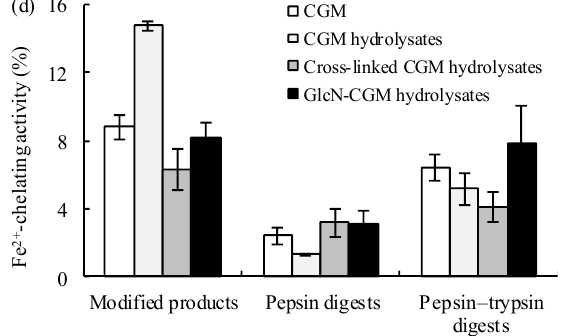
Figure 3. Antioxidant activity of CGM, CGM hydrolysates, cross-linked CGM hydrolysates, GlcN–CGM hydrolysates and their products after being subjected to pepsin and pepsin–trypsin digestions. ( a ) Diphenylpicrylhydrazyl (DPPH) radical-scavenging activity (2.0 mg / mL), ( b ) reducing power (5.0 mg / mL), ( c ) hydroxyl radical-scavenging activity (2.0 mg / mL) and ( d ) Fe 2 + -chelating activity (2.0 mg / mL) ( n = 3, error bars show standard deviation).